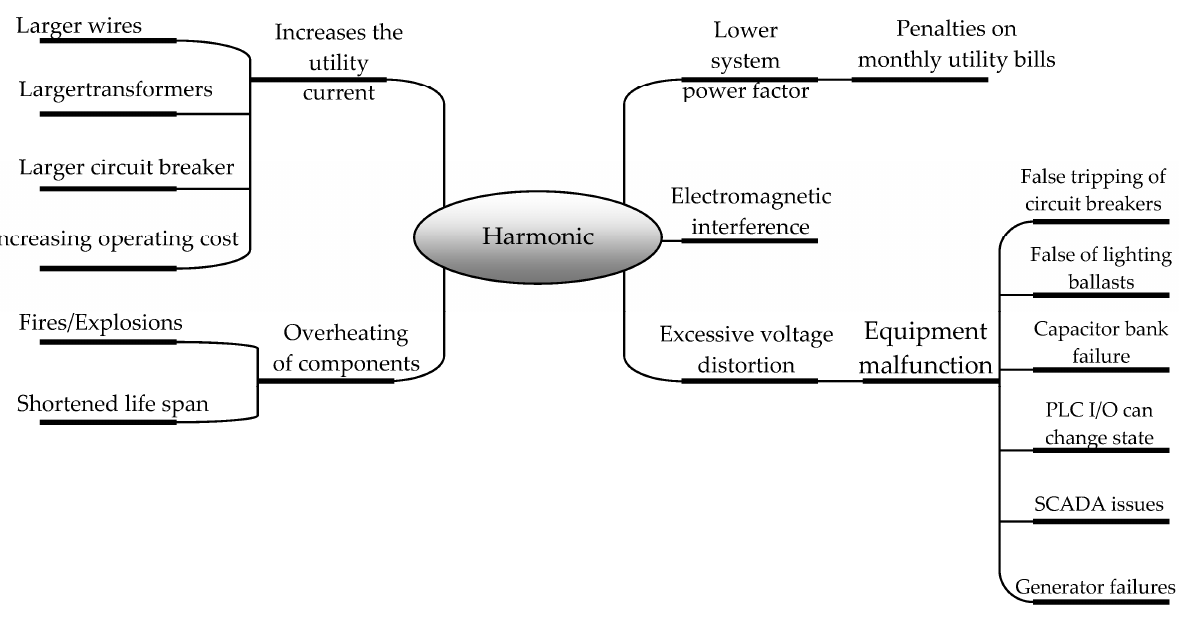
Figure 2. Effects of harmonics.